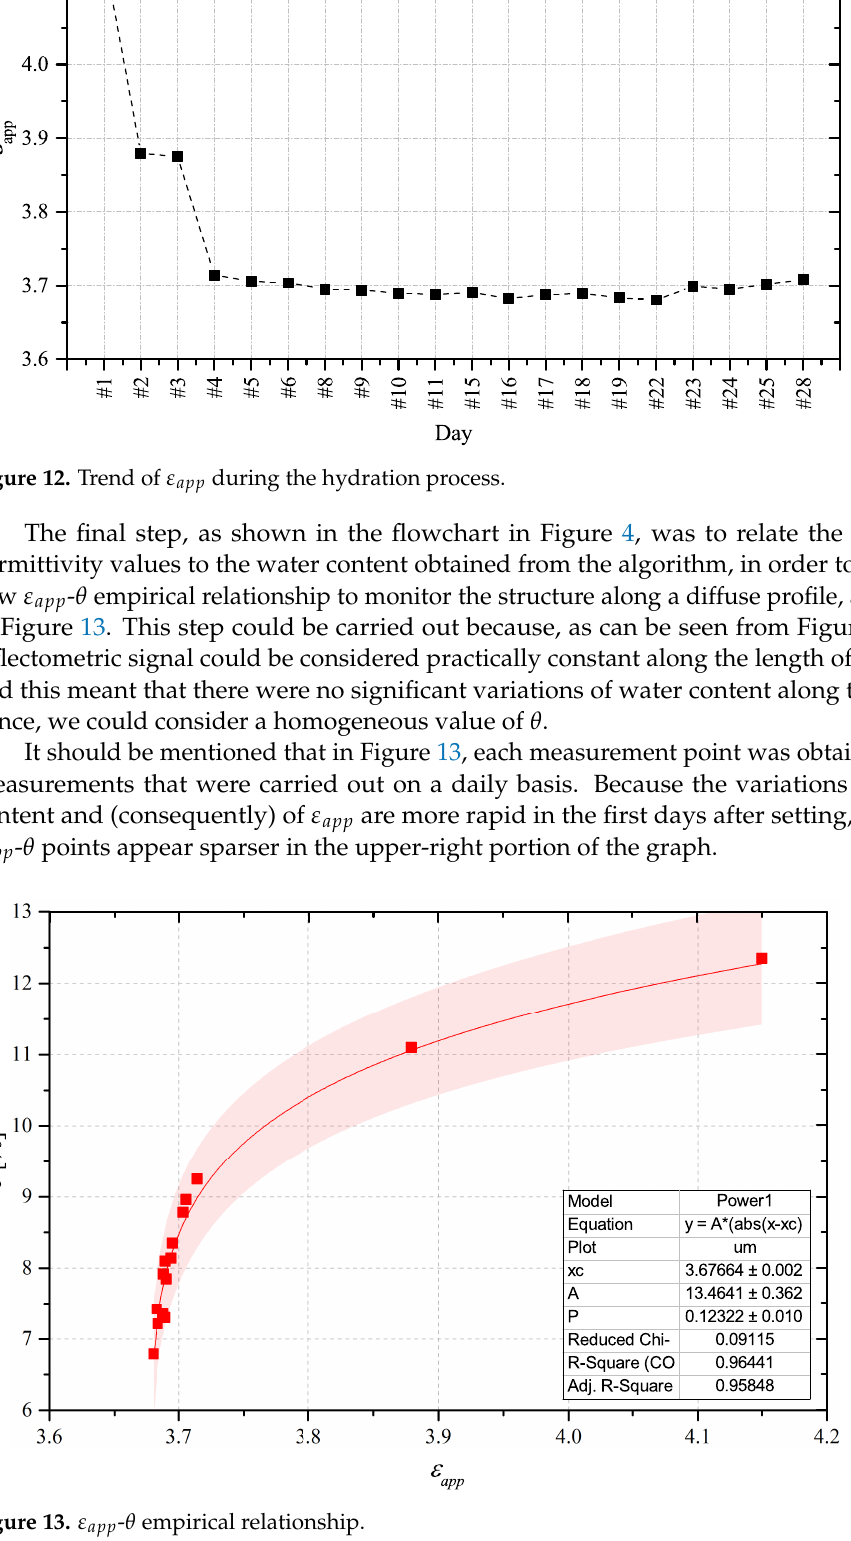
Figure 13. ε app - θ empirical